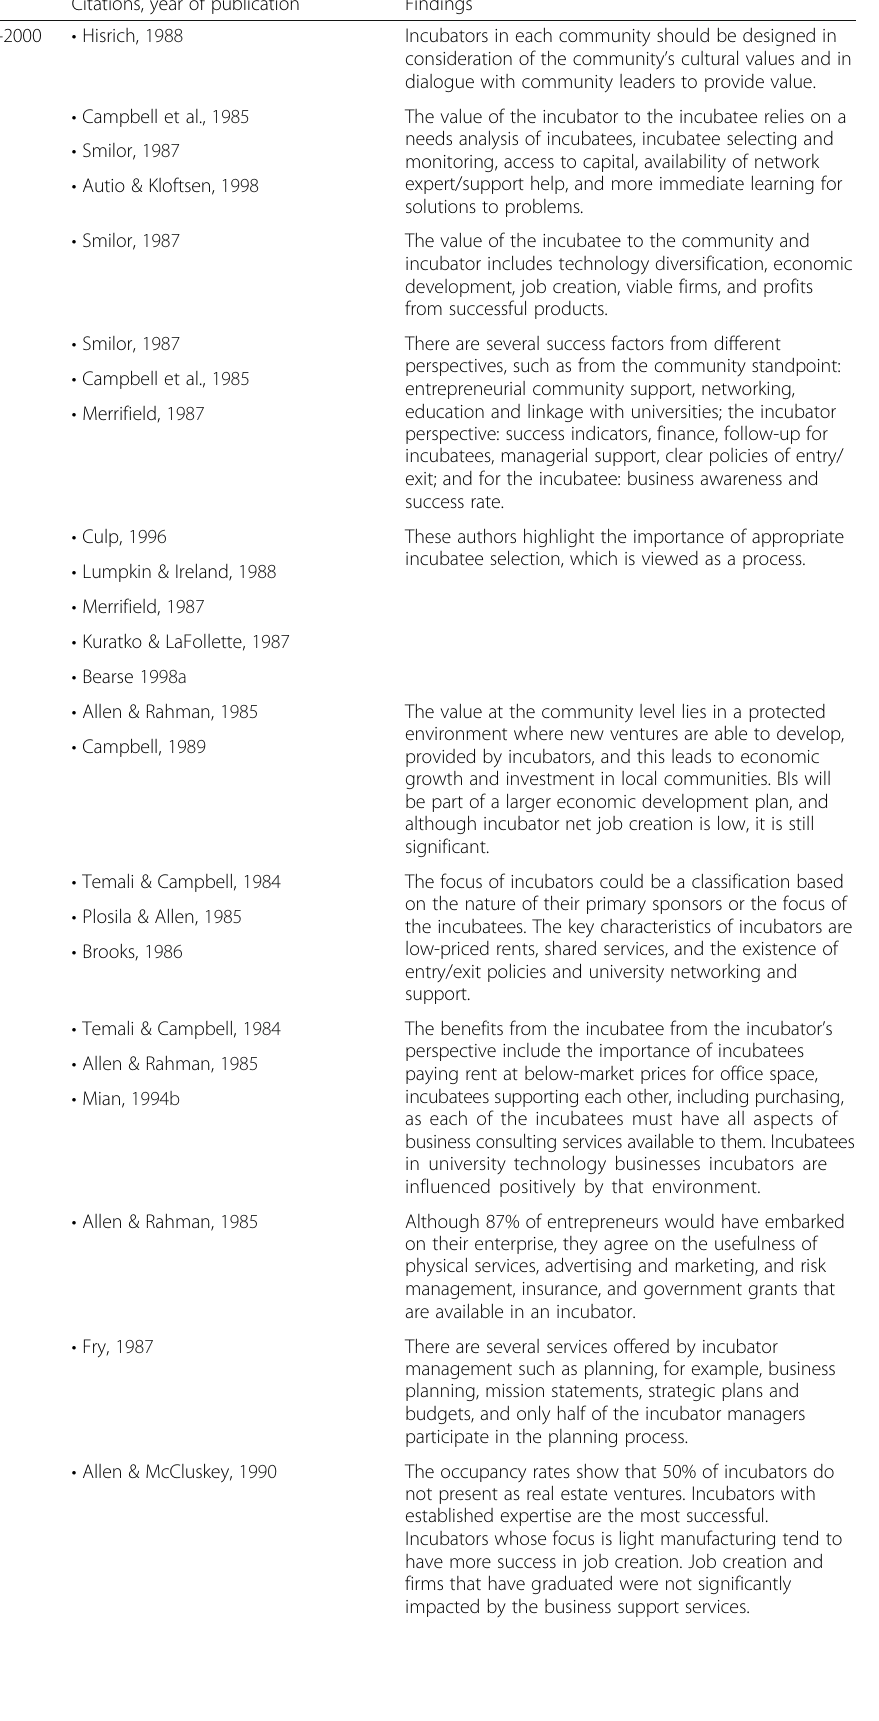
Table 1 Incubators: evidence from the